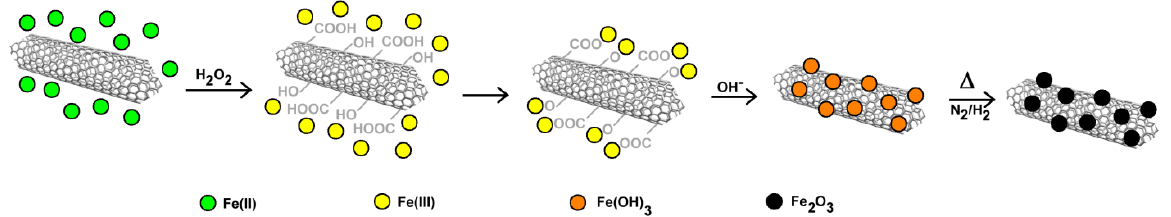
Figure 6. Preparation of magnetic CNTs following the Fenton’s reagent synthetic